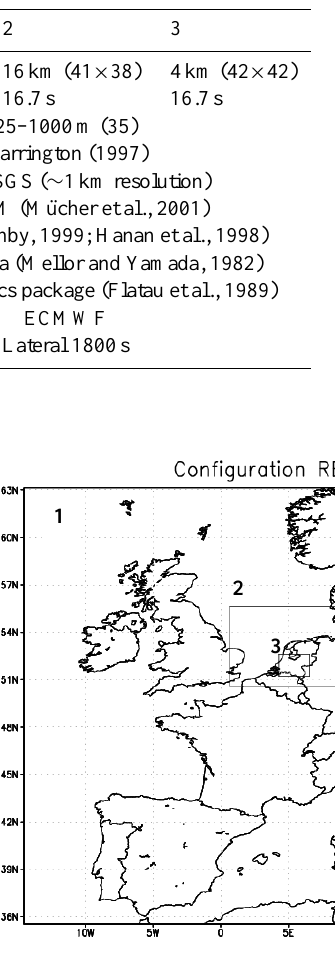
Table 1. RAMS4.3 configuration used in this study.